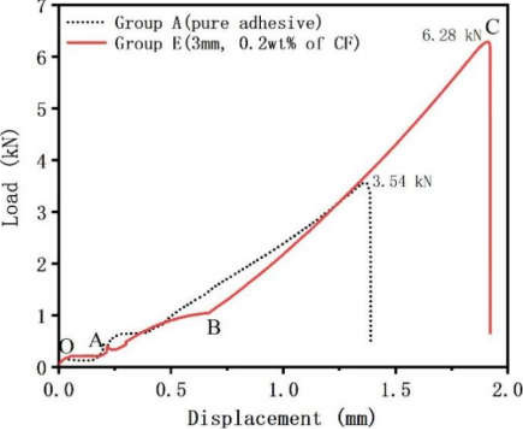
Figure 6. Typical load-displacement curves of group A (pure adhesive) and group E (3 mm, 0.2 wt% of